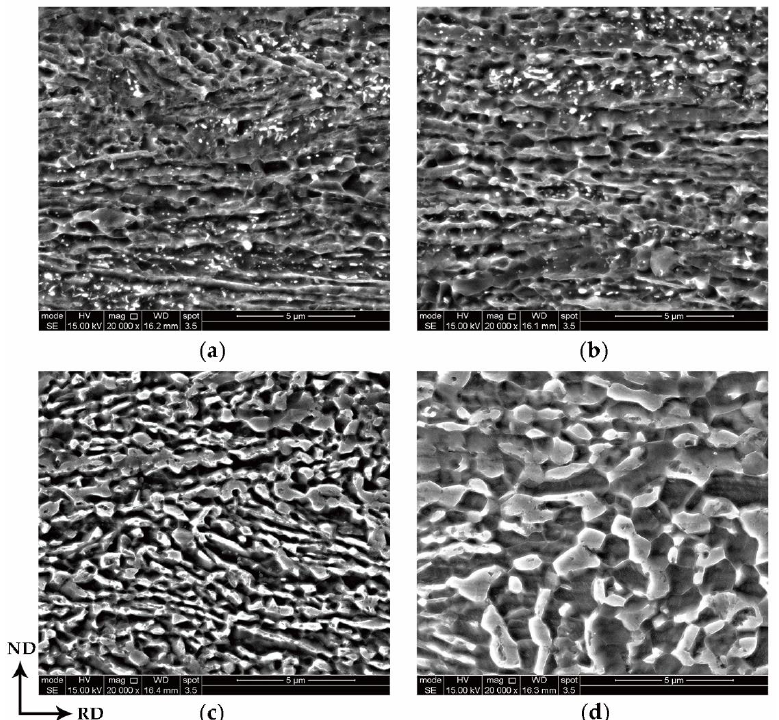
Figure 2. SEM micrographs of the samples intercritically annealed at 675 °C for different times: ( a ) 1 min, ( b ) 3 min, ( c ) 30 min and ( d ) 360 min.